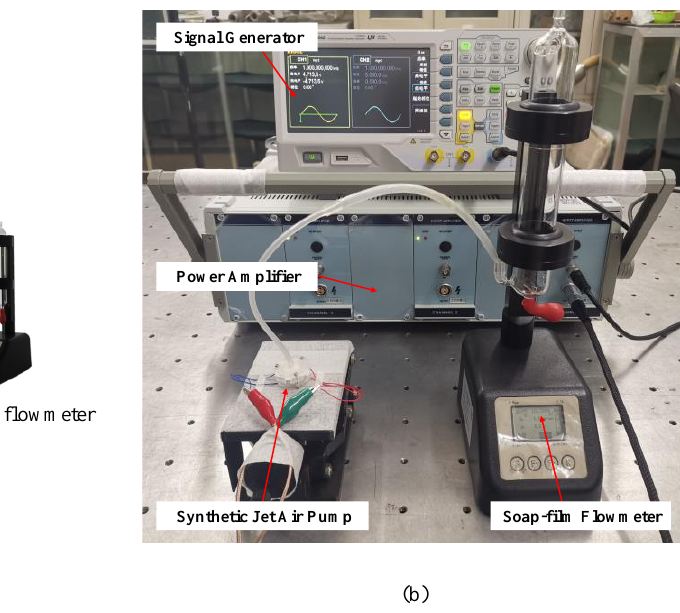
Figure 6. Test of synthetic jet piezoelectric air pump: ( a ). the test system of the synthetic jet piezoe- lectric air pump; ( b ). test platforms of synthetic jet piezoelectric air pump.